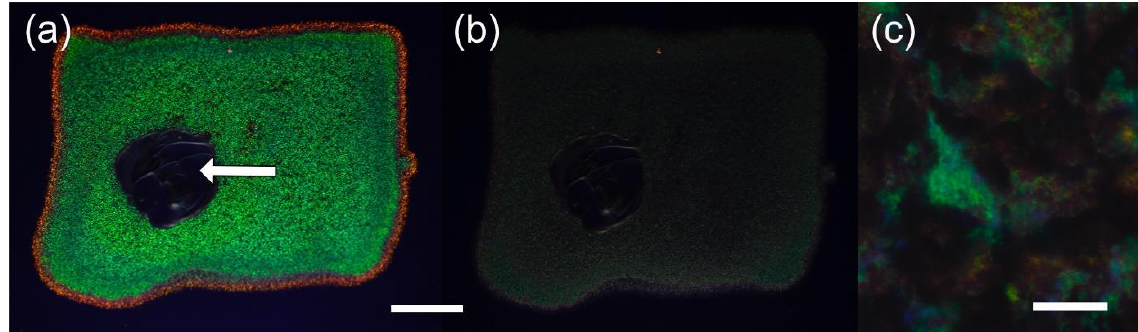
Figure 3. Structural color of Flavobacterium IR1 cultured on nutrient agar containing a black dye for contrast. ( a ) Structural color viewed at the optimal angle. Arrow indicates where the cells were mixed with an inoculation loop, disrupting the photonic crystal and so the coloration. ( b ) As panel ( a ) but viewed from a suboptimal angle for structural color. ( c ) Close up of structural color from panel ( a ) showing that what appears green to the eye is actually a pointillistic arrangement of multiple colors. Scale bars: ( a ) and ( b ) = 6 mm, ( c ) = 20 µm.